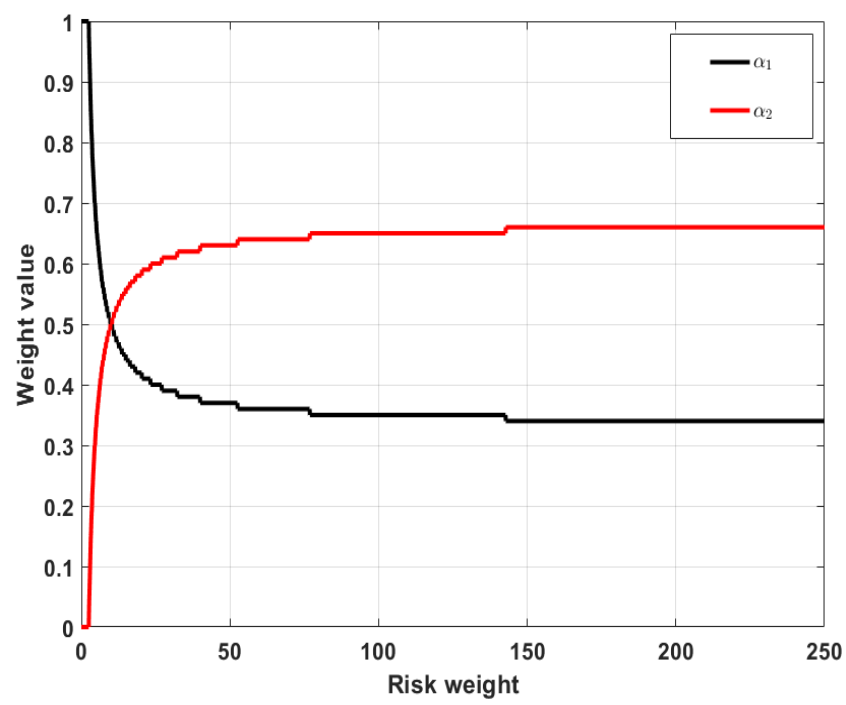
Figure 8. Illustration of the optimal choice of the weights for different risk attitudes ( c ∈ ( 0,250 )